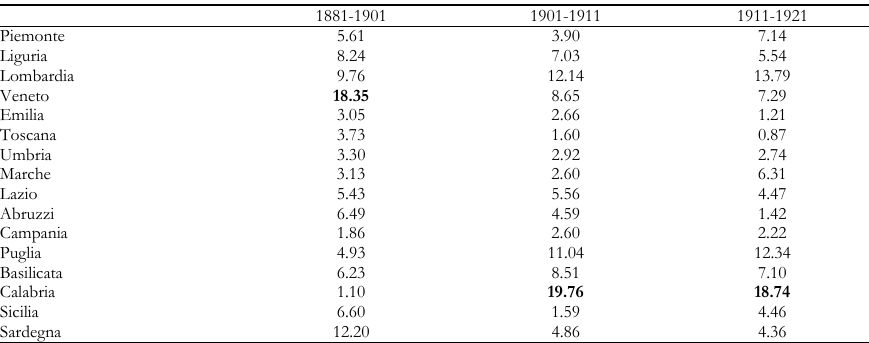
Percent contributions of the regions to the discrepancies between contiguous